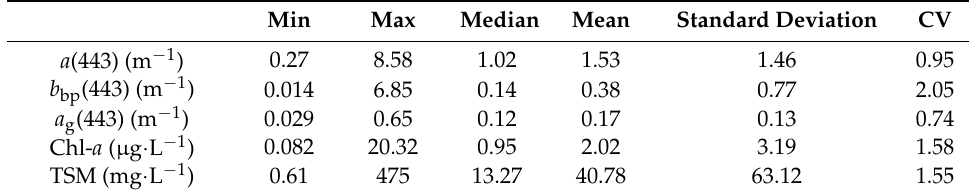
Table 2. Descriptive statistics of water constituent concentrations for the Changjiang estuarine and its adjacent coastal waters (CV is the ratio of standard deviation to the